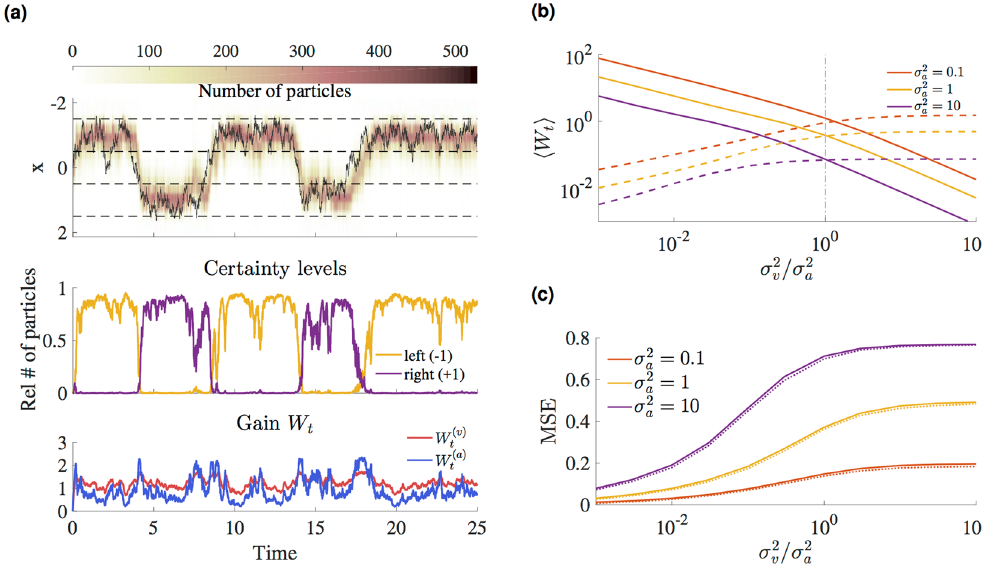
Figure 3. The NPF as a model for perception for multisensory perception. ( a ) Tracking simulation with N = 1000 filtering neurons and sensory noise σ σ = = . 0 1 insect (solid black line) and particle densities. The regions between the dotted black lines denote the two branches, and certainty levels in the middle panel correspond to the relative number of particles whose states are within one of the two branches. At each time, the sensory gains in the lower panel are computed according to Eqs (17) and (18). ( b ) Time-averaged gains W sensory noise in multisensory integration. ( c ) Performance in terms of time-averaged MSE (dotted lines: PF) using both sensory cues v t and a t